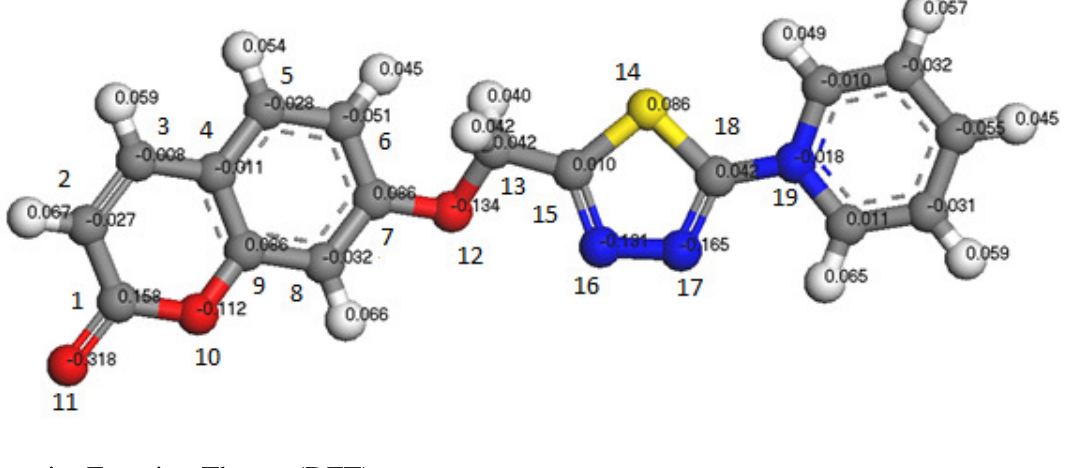
Figure 2. 3d-geometrical structure for the compound 8